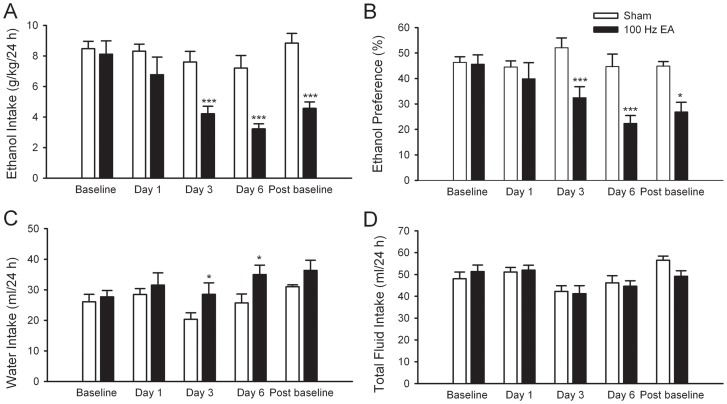
Multiple sessions of high frequency (100 Hz) EA sharply decreased excessive consumption of and preference for ethanol.100 Hz EA or sham was administered to two different groups of rats for 6 consecutive days, 10 min before the start of ethanol- or water-drinking session. The effect was measured on day 1, 3, and 6. There was no significant difference regarding the baseline drinking levels between the EA and the sham group. Rats in EA group (filled bars) but not in sham group (blank bars) sharply reduced ethanol intake (g/kg/24 h) (A) and preference (B) for ethanol at the 24 h after the onset of drinking. EA treatment also increased water intake (C). Total fluid intake was not affected by multiple EA treatment at 24-h time point on all test days (D). The values are expressed as mean ± SEM. *p<0.05, ***p<0.001 compared with sham (two-way RM ANOVA followed by Tukey post hoc analysis), n = 8 animals in each group.